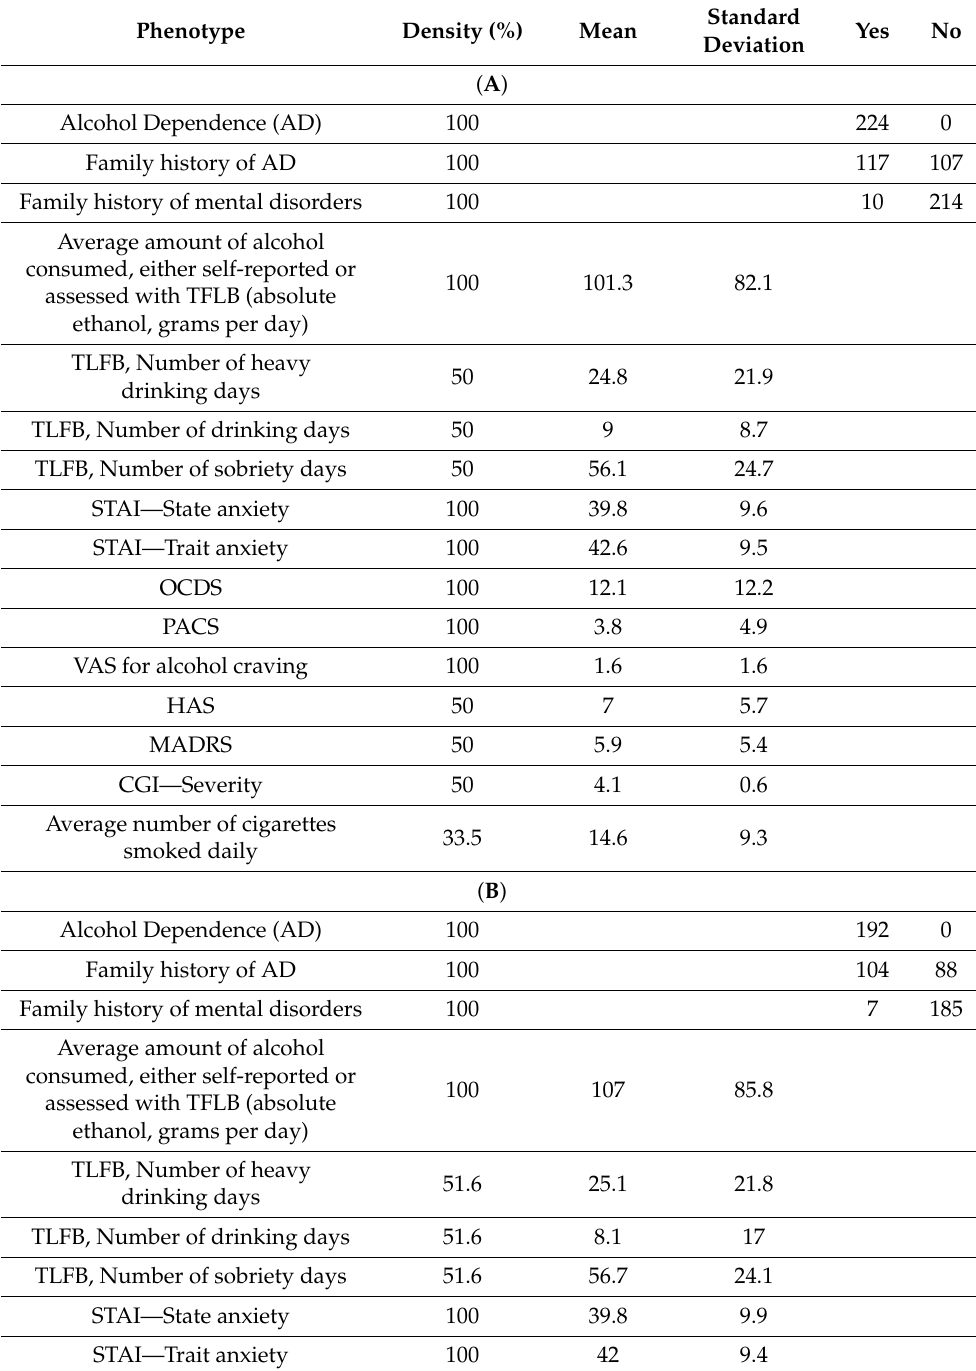
Table 1. (A) Clinical characteristics of the entire cohort of individuals with AD. (B) Clinical characteristics of the male patients with AD. (C) Clinical characteristics of the female patients with